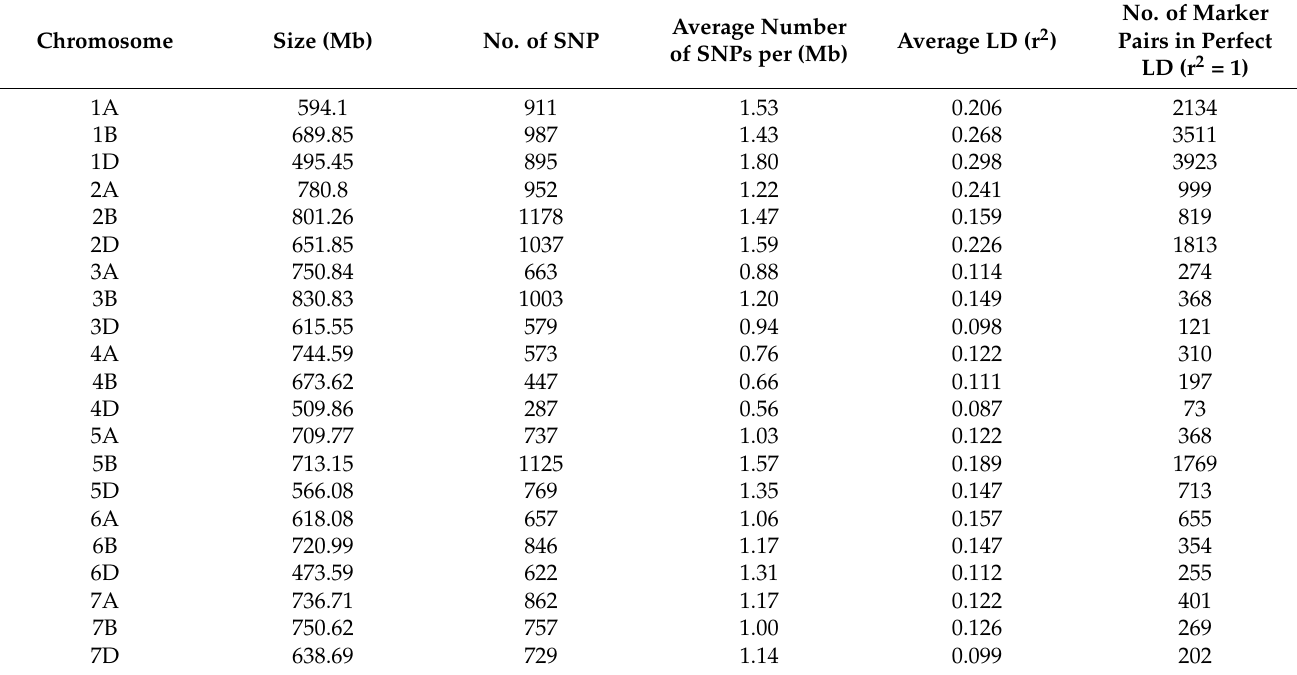
Table 2. Distribution of 16,616 SNPs and identified linkage disequilibrium (LD) on 21 chromosomes in 136 wheat genotypes.